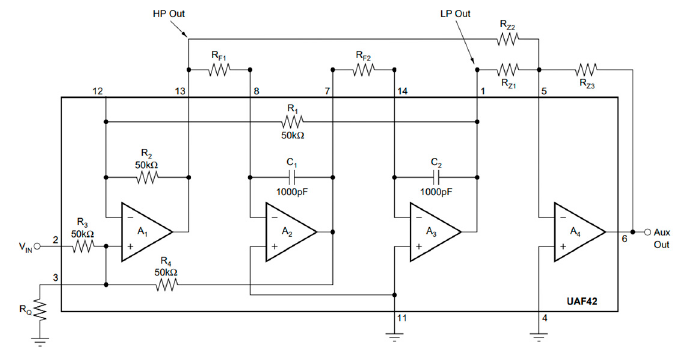
Figure 2. Notch Filter with the UAF42. Table 1. Values obtained for the Notch filter with the Filter 42 program.